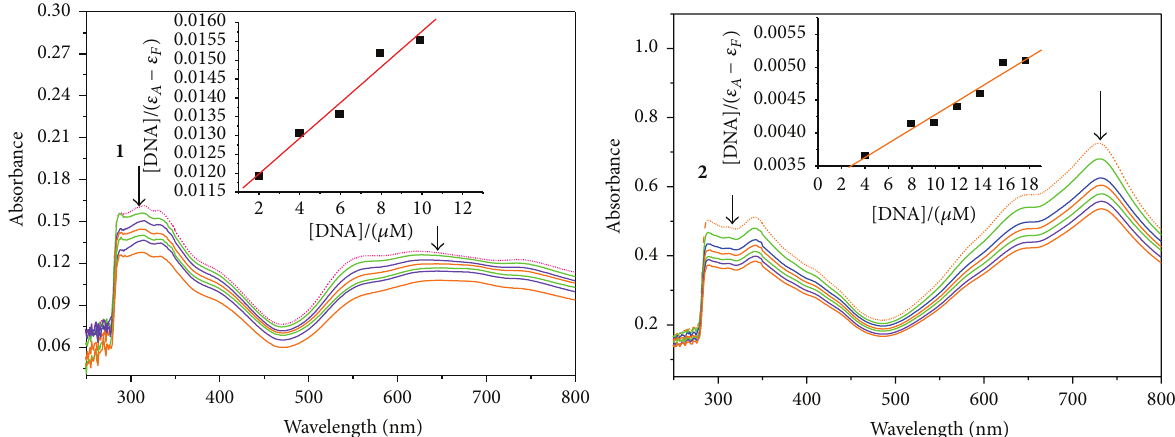
Figure 3: UV-Vis absorption titration of complexes 1 and 2 in Tris/KCl buffer (100mM KCl, 10 mM Tris-HCl, and pH 7.35) with a fixed compound concentration (2.0 × 10 −3 M) and increasing the amounts of G4-HTG21 (1.0 × 10 −5 M, 5 𝜇 L per scan).